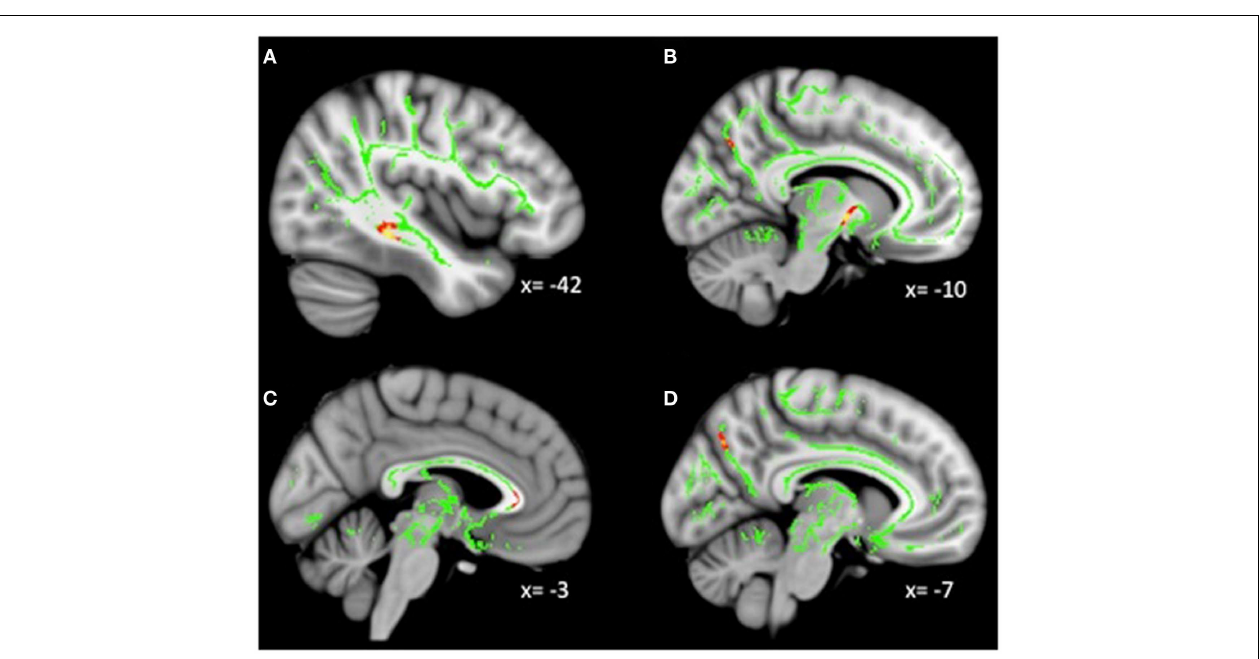
FIGURE 2 | DecreasedWM integrity as depression severity increased in the (A) sagittal stratum near the PHG; (B)ATR near the pallidum; (C) genu of the corpus callosum and anterior cingulate; (D) anterior cingulate near the precuneus . Key: PHG, parahippocampal gyrus; ATR, anterior thalamic